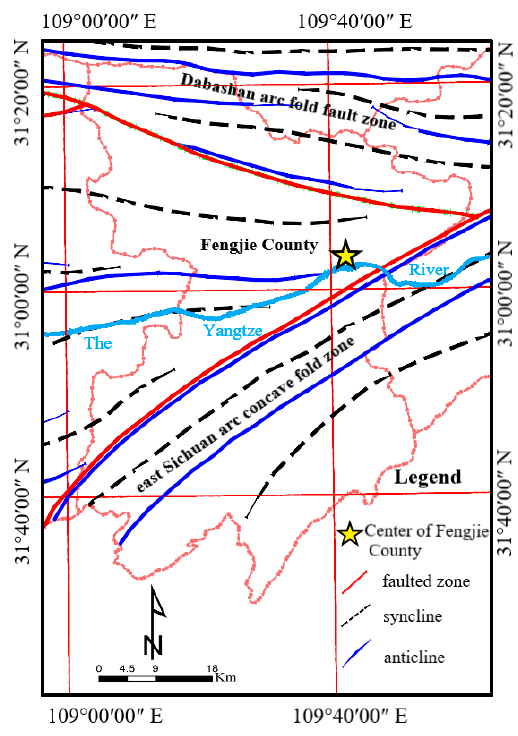
Figure 2. Geological Structure Outline Map of Fengjie County.